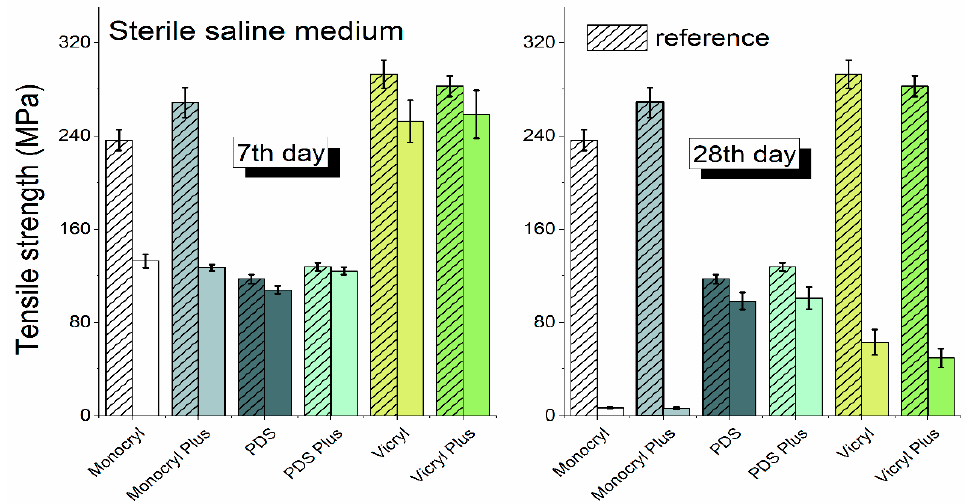
Figure 2. Comparison of the tensile strength of each surgical suture examined in sterile saline on days 7 and 28 of the experiment.